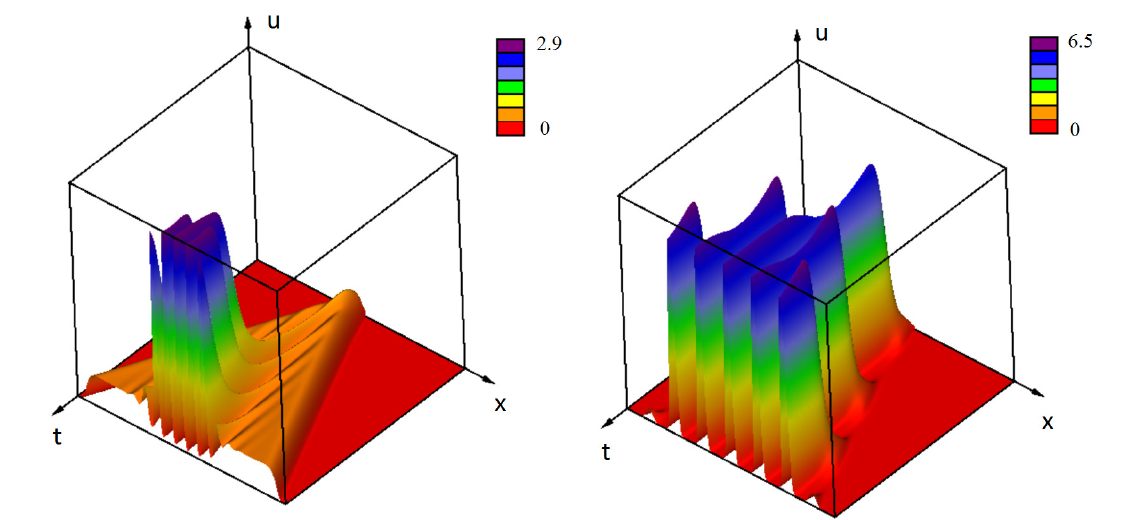
Figure 4. Numerical simulations of Equation (1) show the waves propagating from the center of the interval towards its boundaries in the monostable case. In the first monostable case ( left ) the periodic perturbation propagates slower than the [ u + , u − ] -wave, and the distance between them grows. In the second monostable case ( right ), the periodic perturbation propagates faster, it merges with the wave, and they form a single periodic wave. The values of parameters: D = 10 − 5 , r = 1, q = 1, k 1 = 5, k 3 = 3, N = 0.035 ( left ), N = 0.1 ( right ); f ( u ) = k 1 ue − k 3 u , τ =